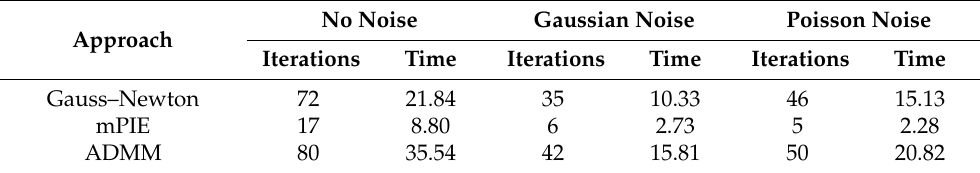
Table 3. Runtime performance comparison of algorithms.